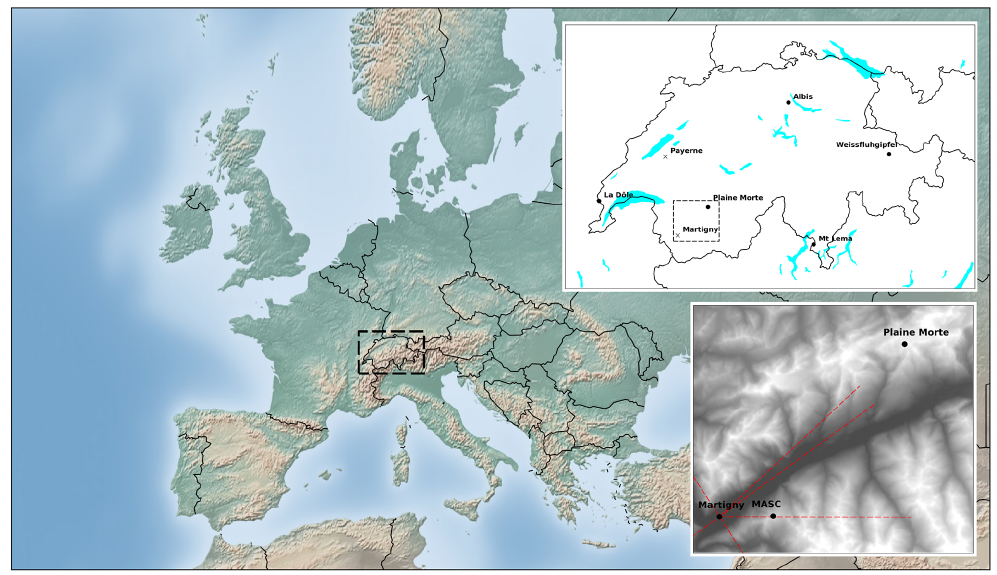
Figure 1. Locations of the study areas (Payerne and Martigny) within Switzerland (top right panel) and the scan directions for the RHI scans during the Valais campaign (lower right panel).